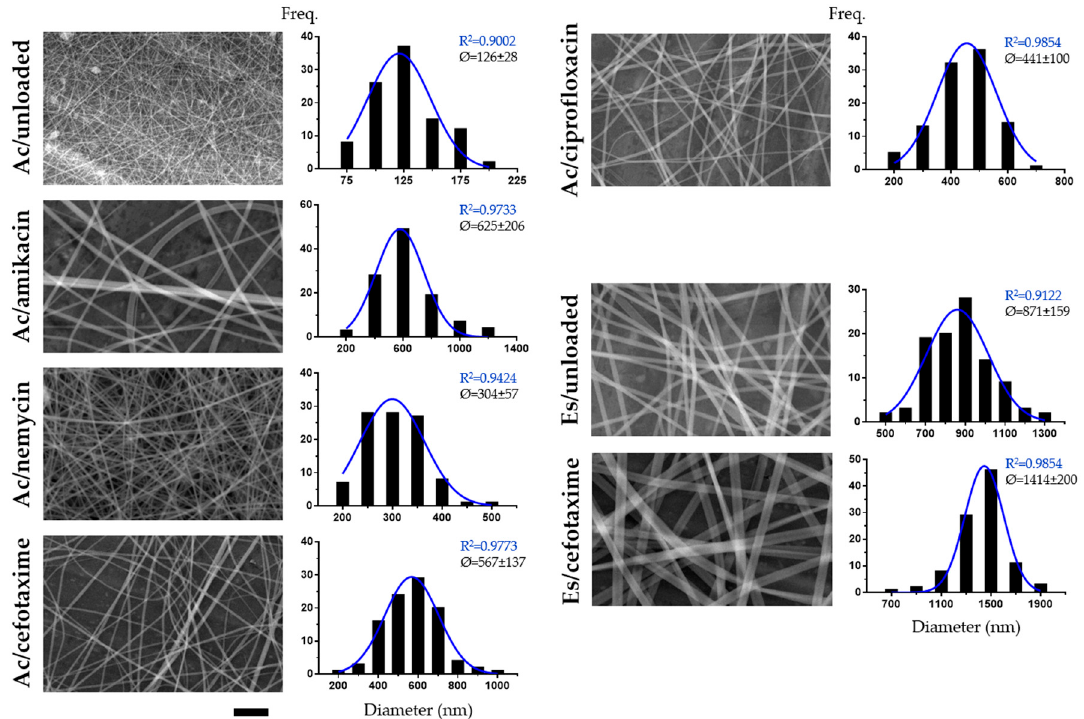
Figure 2. SEM analysis of antibiotic ‐ loaded electrospun nanofibers. Representative SEM micrographs and corresponding diameter frequency histograms for PMVE/MA ‐ Ac, PMVE/MA ‐ Ac/amikacin, PMVE/MA ‐ Ac/neomycin, PMVE/MA ‐ Ac/cefotaxime, PMVE/MA ‐ Ac/ciprofloxacin, PMVE/MA ‐ Es and PMVE/MA ‐ Es/cefotaxime. Histogram data were obtained from multiple micrographs (100 individual measurements). Best ‐ fit adjustments (and their R 2 ) to a Gaussian distribution are indicated in blue. Average diameter (Ø) ± s.d. is also stated. Scale bar: 5 μ m.